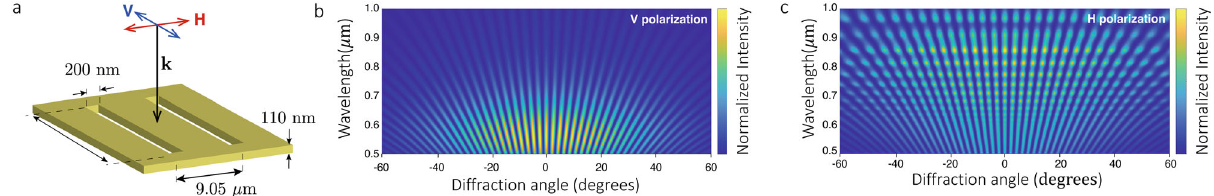
Fig. 5 Design of plasmonic nanostructures. The design of our plasmonic sample is shown in ( a ). The wavelength-dependent far- fi eld interference pattern as a function of the diffraction angle is shown in ( b ). In this case, the structure is illuminated with vertically-polarized photons and no plasmonic near fi elds are excited. The fi gure in ( c ) shows a modi fi ed interference structure due to the presence of plasmonic near fi elds. In this case, the illuminated photons are polarized along the horizontal